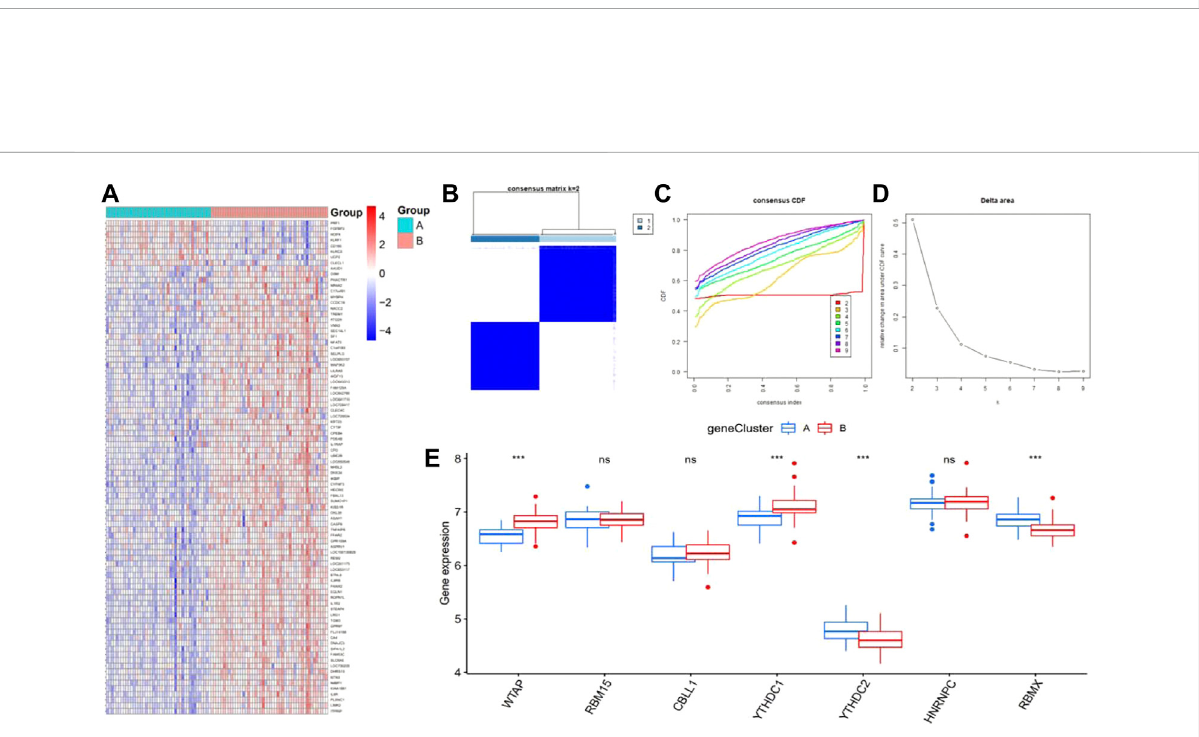
FIGURE 7 Consensus clustering of the 87 RNA N6-methyladenosine (m6A)-related differentially expressed genes (DEGs) in epilepsy, ILogFCI > 0.35, p -value < 0.05. (A) Expression heatmap of the 87 m6A-related DEGs between gene clusterA and gene clusterB. (B – D) Consensus matrix of k = 2, as well as the CDF curve and relative change in the area under the CDF curve for k = 2 – 9 (E) Differential expression of seven signi fi cant m6A regulators between gene cluster A and gene cluster (B) * p < 0.05, ** p < 0.01, and *** p <